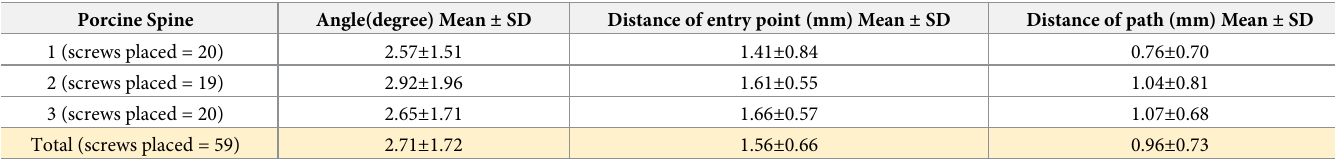
Table 1. Comparison between actual pedicle screw position and preoperative planning